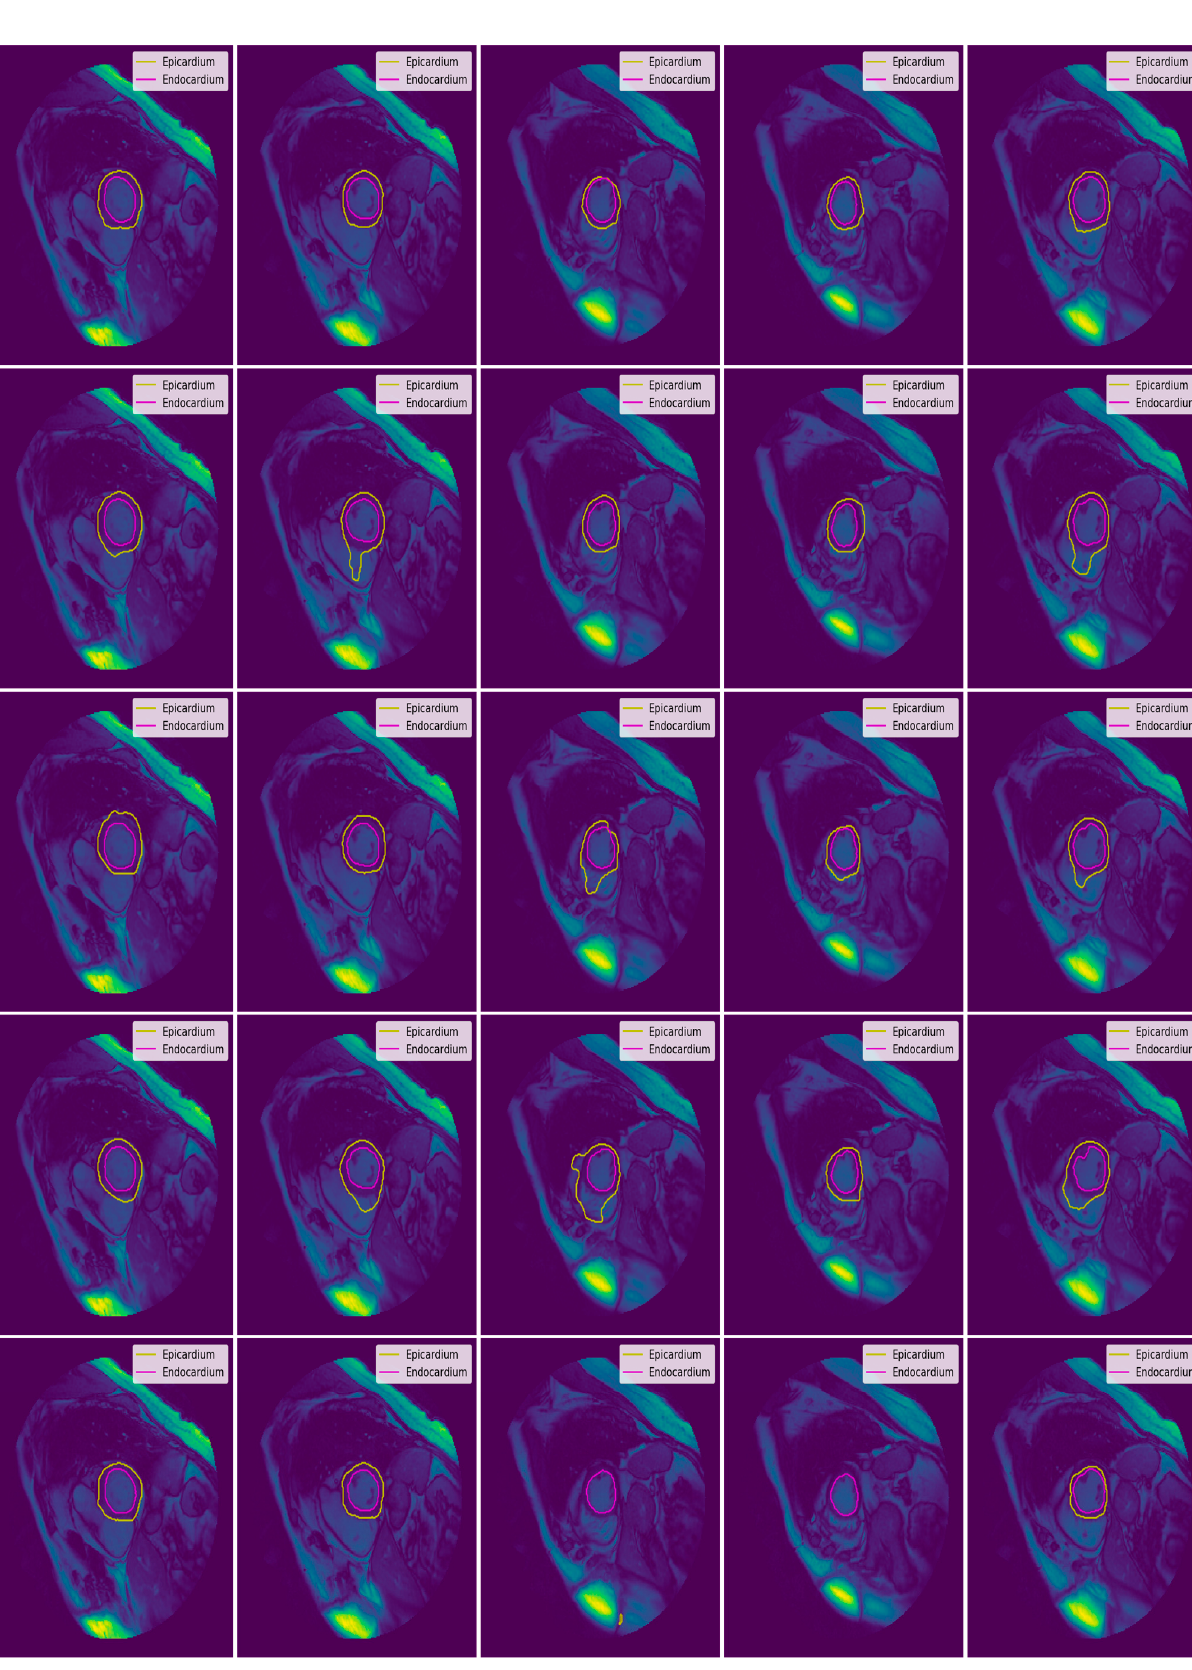
Figure 20. Automatic segmentation results of epicardium and endocardium boundaries from the validation set of a normal patient (SC-N).